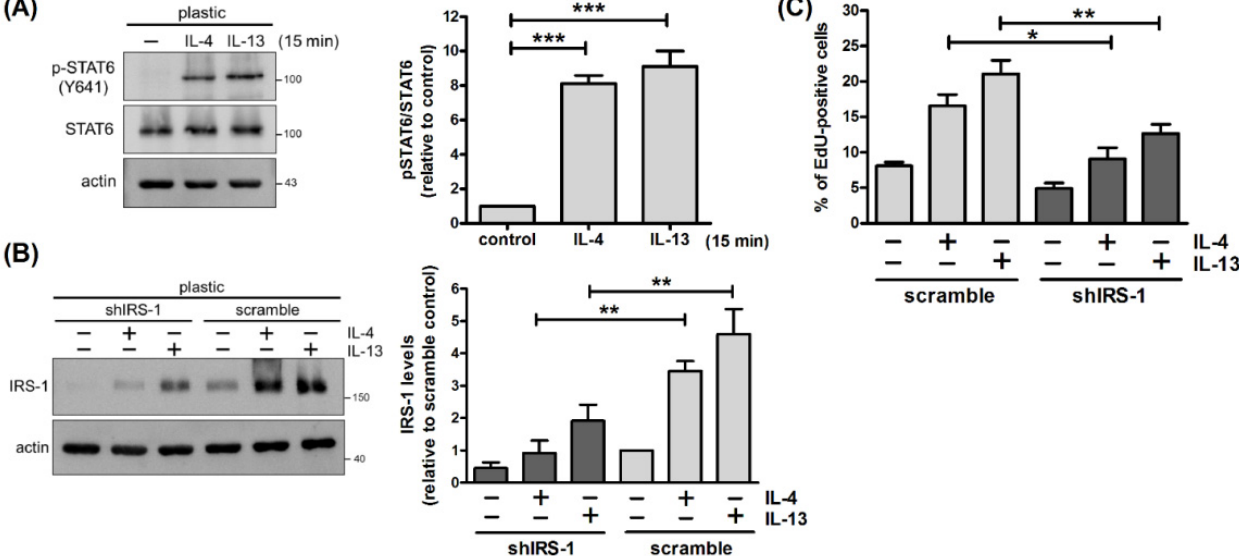
Figure 6. Lowering IRS-1 levels reduces IL-4- and IL-13-stimulated cell proliferation. ( A ) Mammary cells cultured on tissue culture plastic were untreated or treated with IL-4 or IL-13 for 15 min. Total cell lysates were analyzed by immunoblotting with antibodies to phospho-STAT6 (p-STAT6), STAT6 and actin. Actin was used as a loading control. Data were quantified, normalized to loading control, and expressed as fold change (pSTAT6/STAT6) relative to control ( n = 4). *** p < 0.005. ( B , C ) Mammary cells cultured on plastic were infected with lentivirus carrying shRNA against Irs1 (shIRS-1) or scramble RNA for 2 d, and then stimulated with IL-4 or IL-13 for 2 d. ( B ) Total cell lysates were analyzed by immunoblotting with antibodies to IRS-1 and actin. Data were quantified, normalized to loading control, and expressed as fold change relative to scramble control ( n = 4). ** p < 0.01. ( C ) Prior to harvesting, cells were pulsed with EdU (10 µ M) for 15 h. Nuclei were stained with Hoechst 33342. The percentage of EdU-positive cells was determined by TissueFAXS TM cytometry ( n = 4). * p < 0.05, ** p < 0.01.